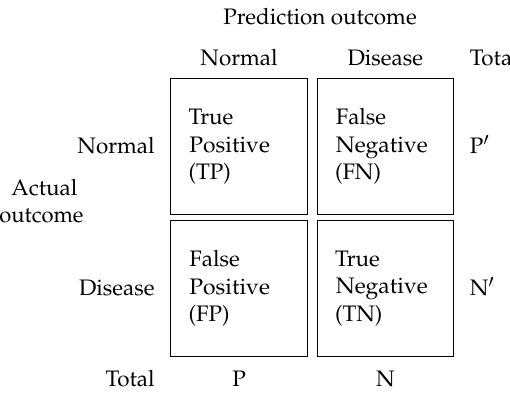
Figure 2. A contingency table for a binary classification